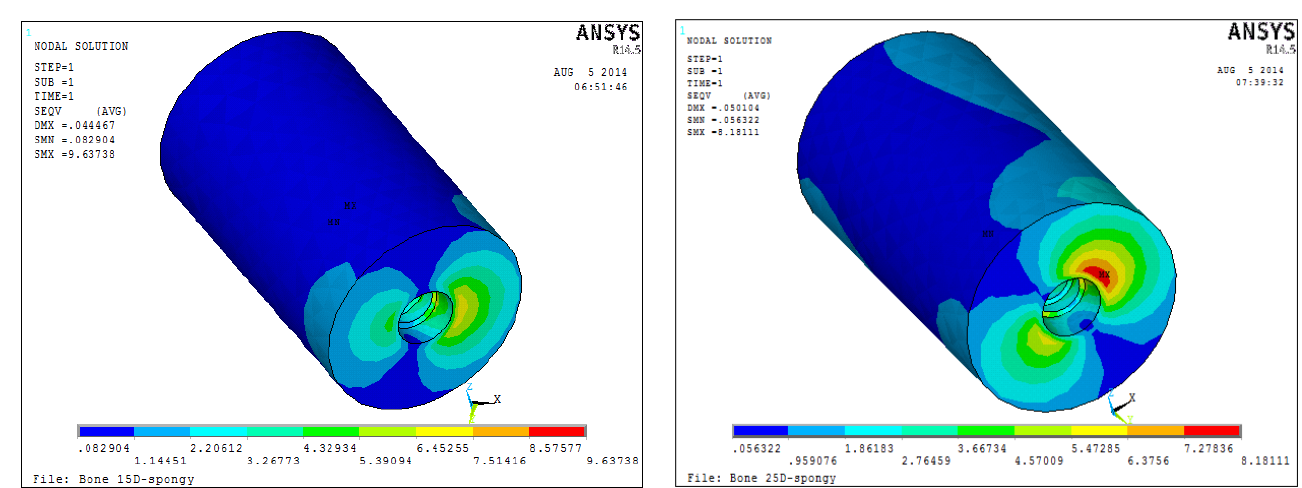
Fig. 4: Spongy bone Von Mises stress distribution comparison between (a) 15°, (b) 25° angulated abutment under IPS E-Max CAD crown.